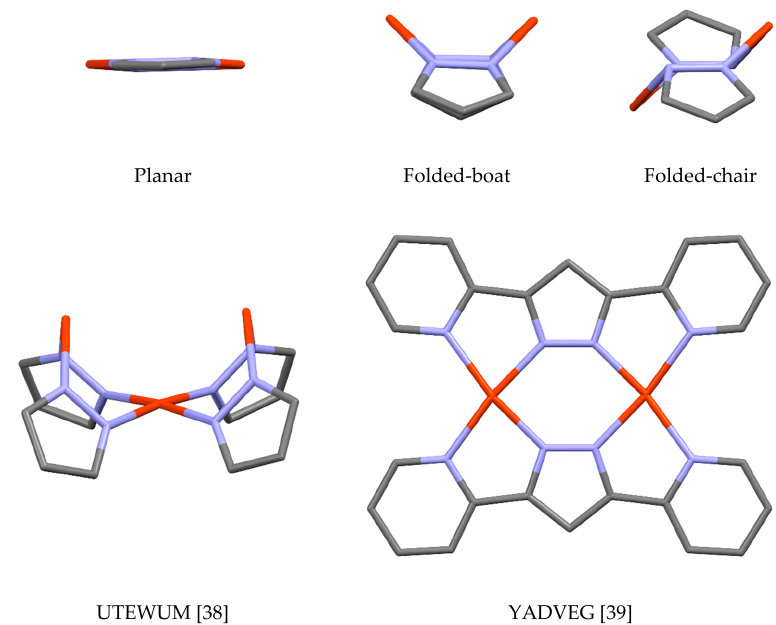
Figure 3. Planar and folded conformations of the metallacycle in (pzCu) 2 (simplified representations of UTEWUM and YADVEG).